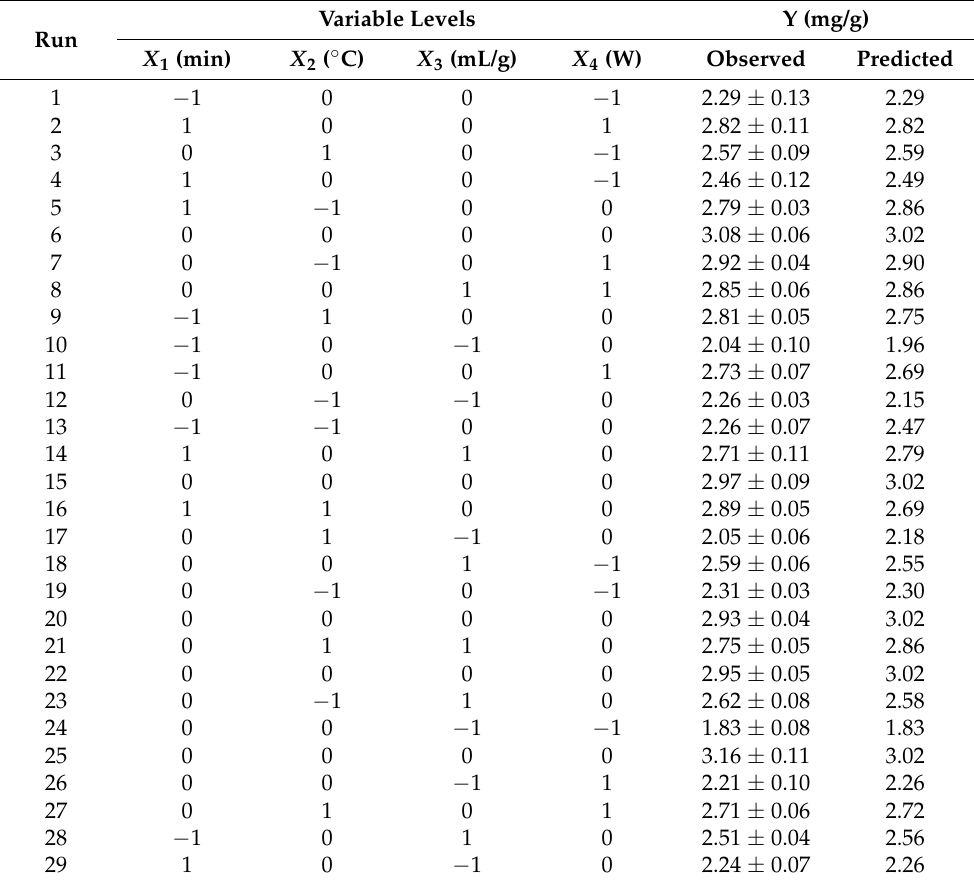
Table 1. The experimental design, actual value, and the predictive value by the response surface methodology (RSM) model.